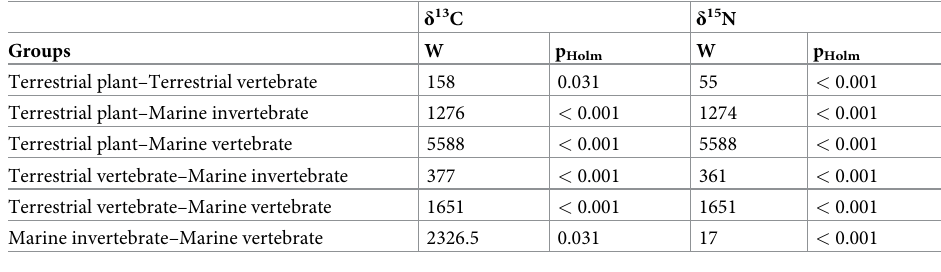
Table 1. Results of Wilcoxon’s rank sum tests for differences in delta values of food groups. δ 13 C δ 15 N Groups